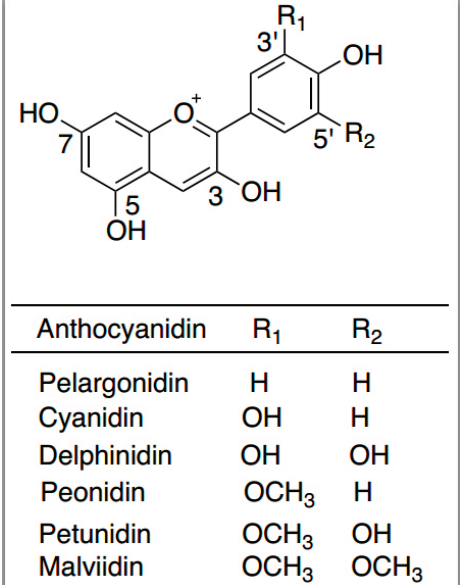
Figure 3. Structural formulas of common